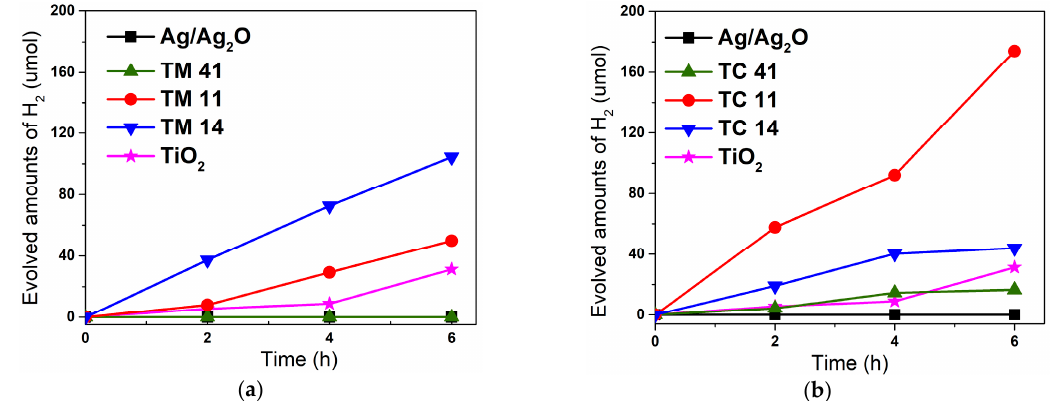
Figure 5. The amount of H 2 evolved from aqueous methanol under UV/vis illumination of Ag/Ag 2 O, TiO 2 , ( a ) TM mixtures and ( b ) TC composites vs. illumination time.